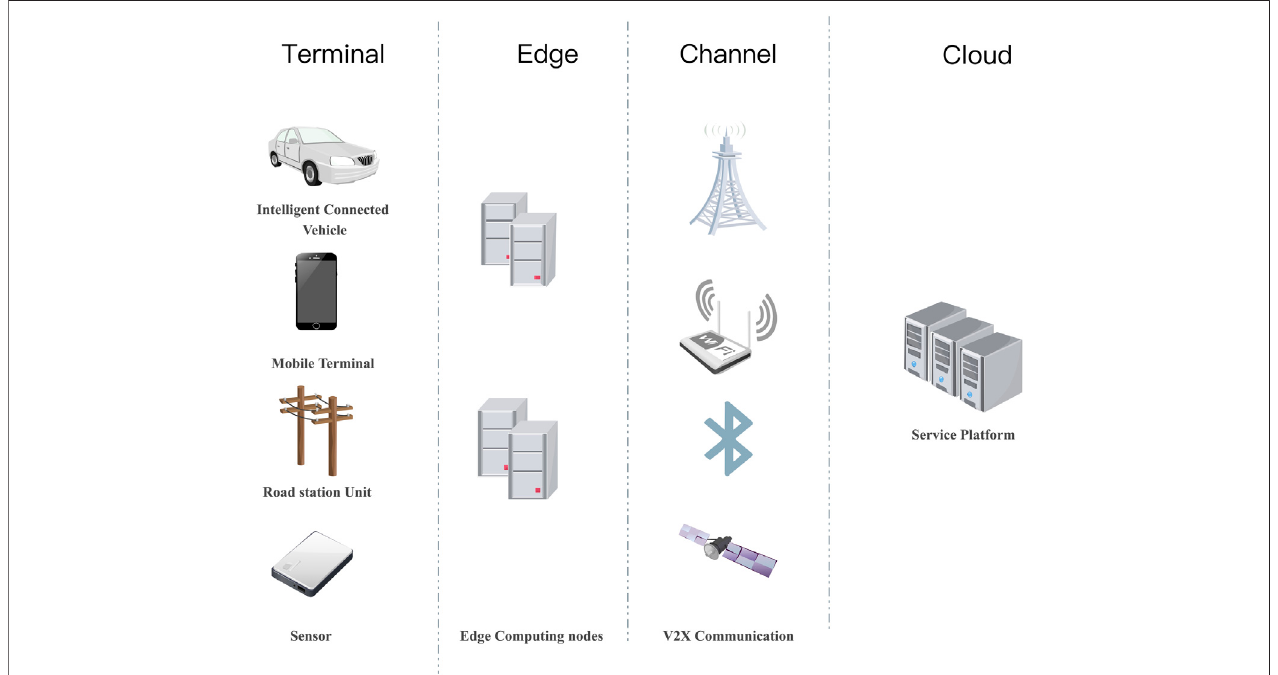
FIGURE 1 | The “ cloud-channel-edge-terminal ” architecture of the